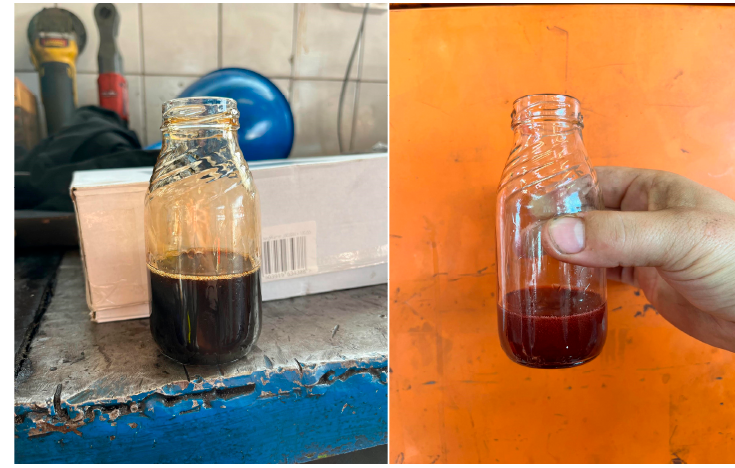
Figure 1. The automatic transmission fluid before and after the oil change.